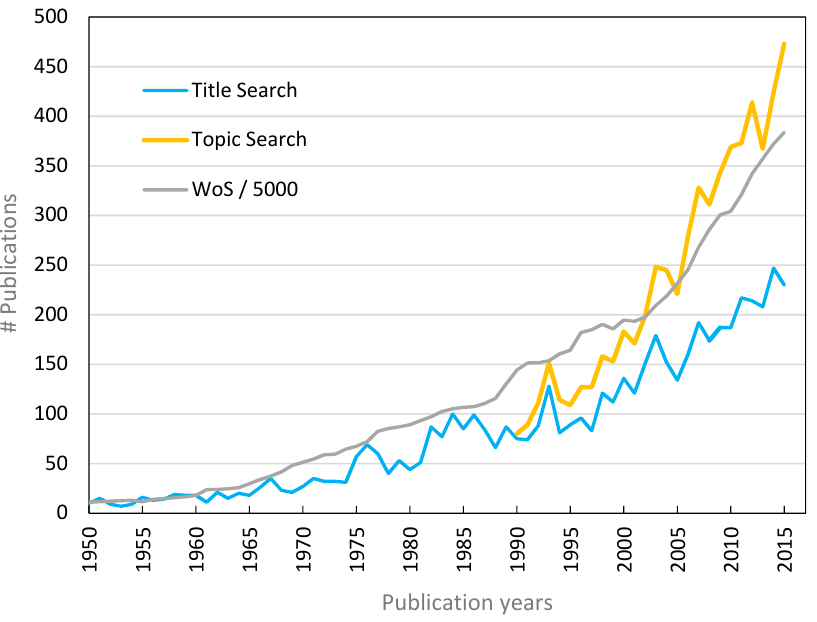
Figure 1. Number of publications per year with the title words “Maya”, “Mayas”, “Mayan”, or “Mayans”. For comparison, the time curve of the overall number of publications in the database divided by 5000 is included. Source: WoS.